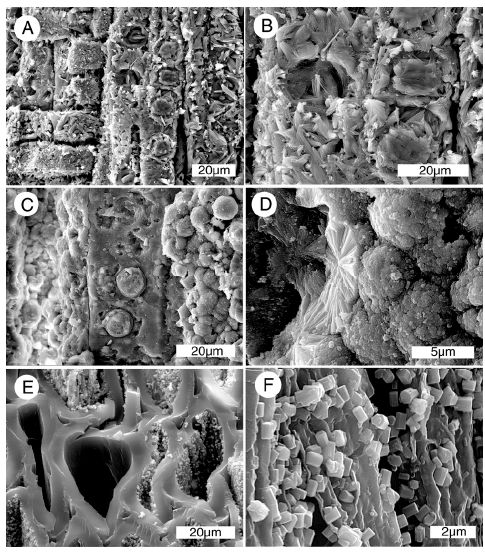
Figure 19. Phosphatized wood from other Cenozoic localities. ( A , B ) Radial views of Miocene wood from Virgin Valley Formation, northern Nevada, USA, mineralized with fluorapatite; ( C,D ) Neogene fluorapatite wood from Sante Fe River (FL, USA); ( E , F ) Apatite crystals on carbonized cell walls, Eocene, Yuba River, Nevada County (CA, USA). Specimens from G. Mustoe research collection, apatite compositions determined by SEM/EDS.